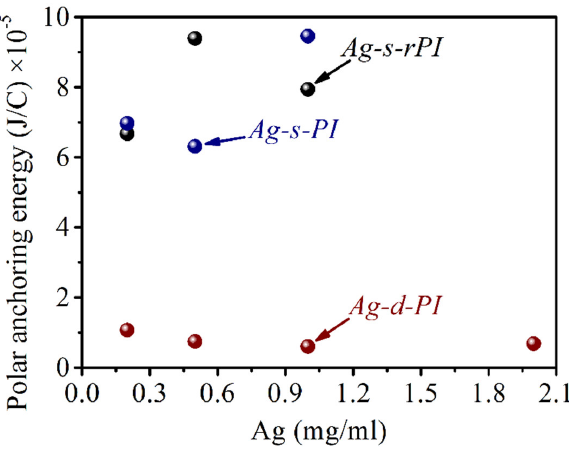
Figure 5. The polar anchoring energy of LC sandwiched between Ag-s-rPI alignment layers, Ag-s-PI alignment layers and Ag-d-PI thin layers,